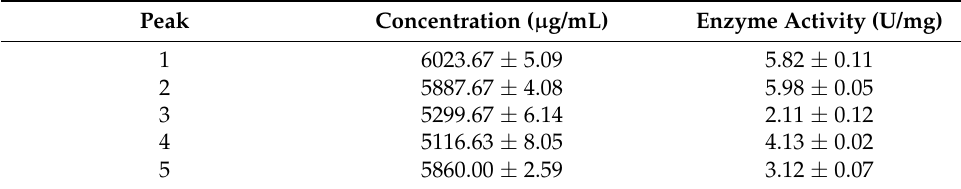
Table 1. Comparison of concentration and enzyme activity of the five protein fractions.